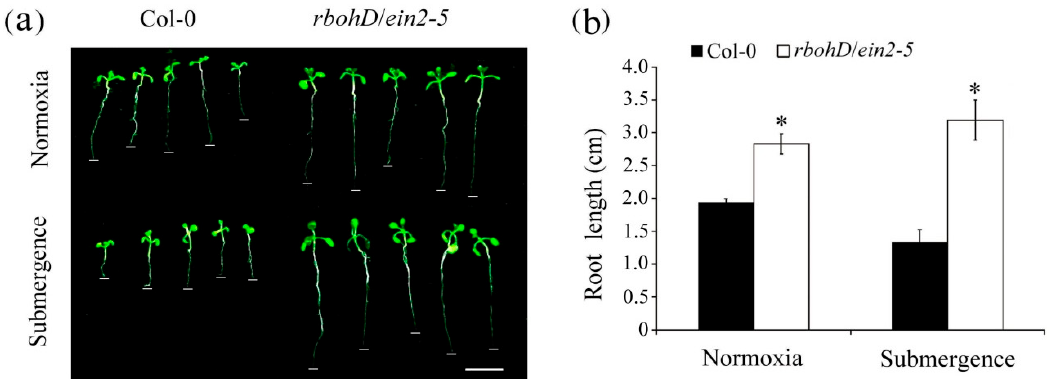
Figure 4. Comparison of root growth in wild-type and rbohD / ein2-5 double mutant seedlings after submergence. ( a ) Phenotypes of seedlings grown on 1 / 2 MS medium for 14 d and then treated with submerged conditions for an additional 7 d. Bar = 1 cm. ( b ) Average root length of seedlings grown under normaxic condition and submerged conditions. Error bars represent SD for at least 100 seedlings of each genotype, obtained from three biologically independent experiments. * p < 0.05, versus wild-type plants (Student’s t test).